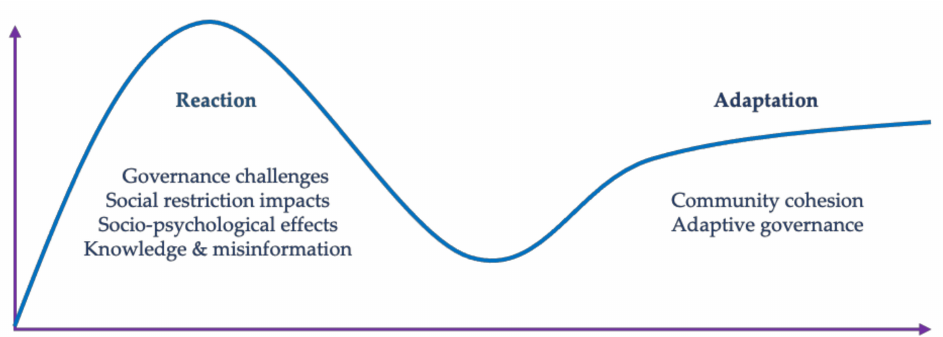
Figure 2. Themes categorizing studies from the literature review focused on reaction and